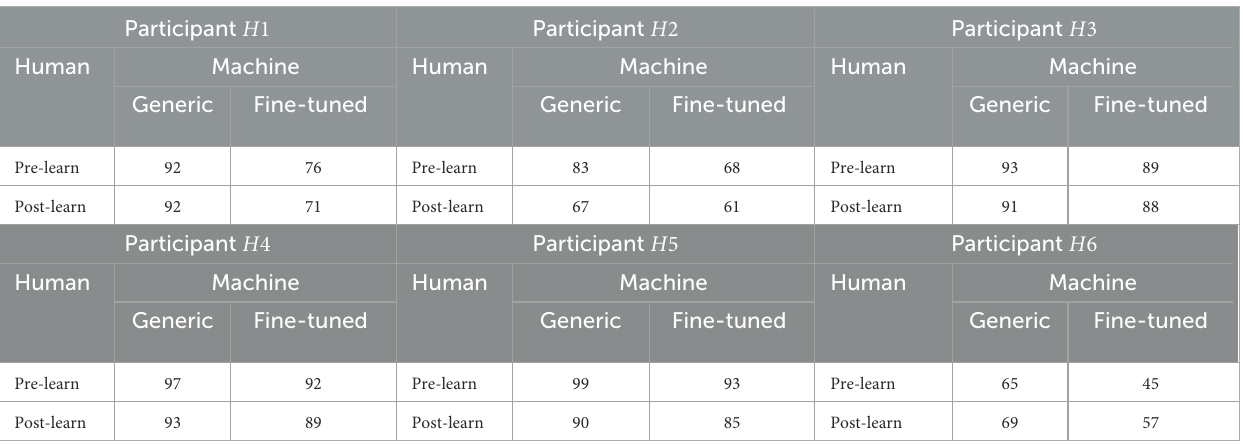
TABLE 3 The number of mismatches between words whose images were displayed ( L expected ) and labels predicted by generic (resp. fine-tuned) speech-to-text